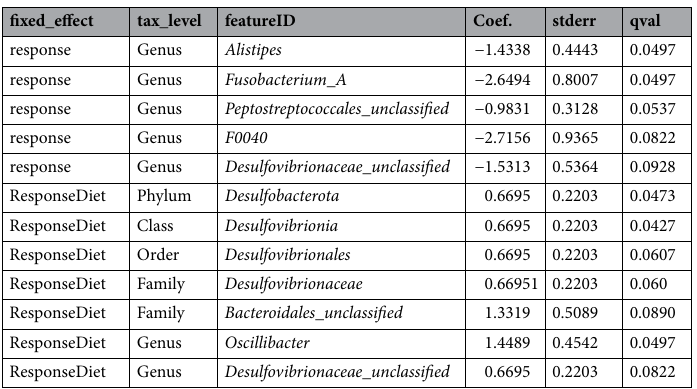
Table 2. Dietary response analysis in cats with chronic enteropathy. Significance of feature coefficients in linear model where fixed effects are diet, response, and interaction of the two (ResponseDiet).